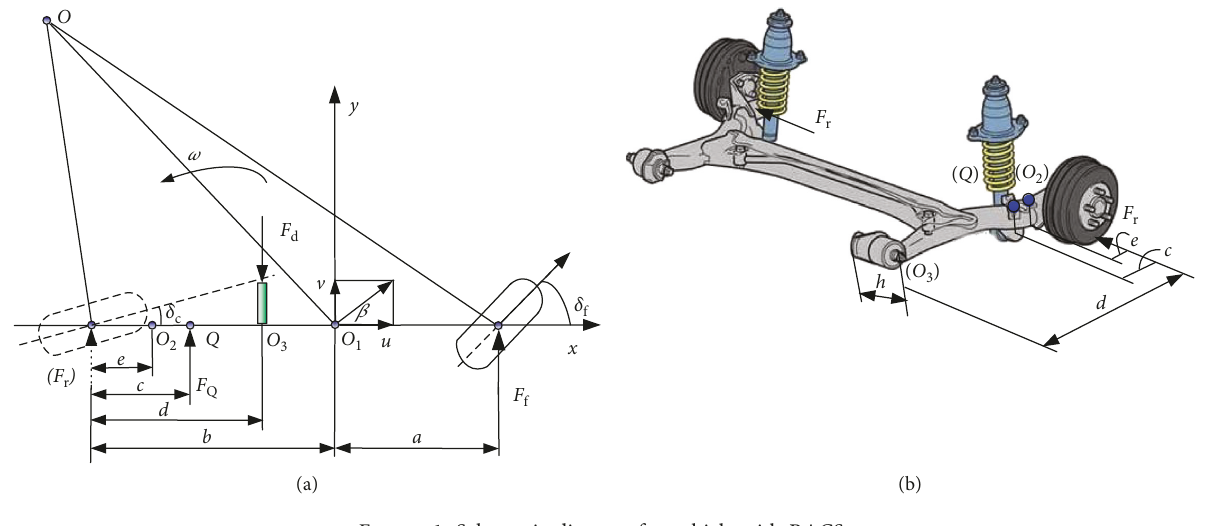
Figure 1: Schematic diagram for vehicle with RACS. Table 1: Parameters of magic formula tire